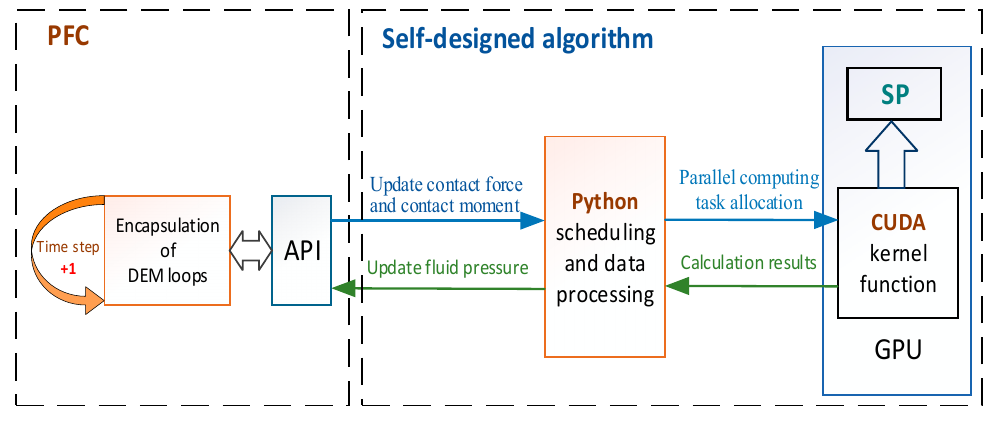
Figure 6. DEM-SP model implementation architecture.